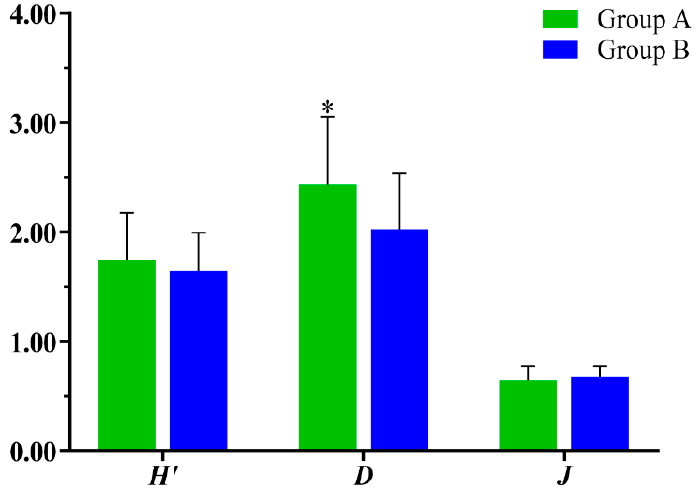
Figure 5. Spatial variances of the species diversity for the di ff erent groups. H’ , D and J represent the Shannon–Wiener index, Margalef index and Pielou’s index, respectively.